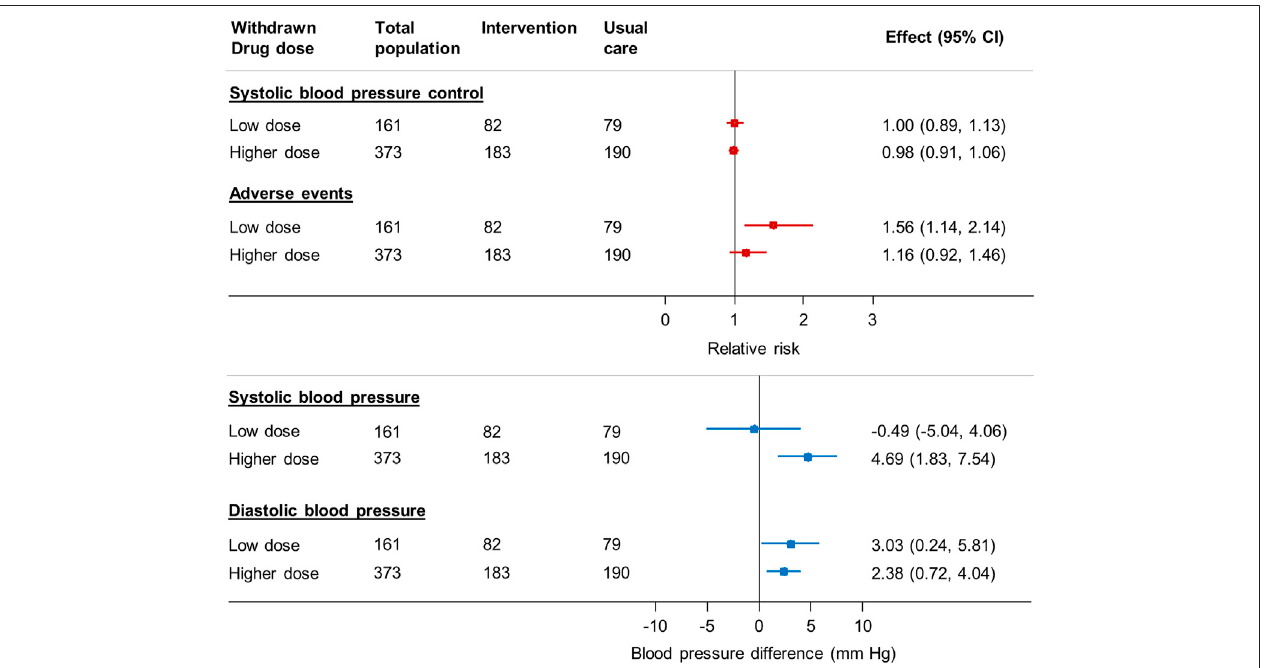
FIGURE4| Relativeriskofbloodpressurecontrol,adverseeventsandmeanchangeinbloodpressureinpatientsreducingantihypertensivemedicationcompared to usual care, by dose of medication chosen for withdrawal* *Since the treating physician ’ s choice of medication to withdraw was made prior to consent and randomization, data were available for all randomized participants, even though only half went on to have the medication withdrawn in the trial. BP (cid:2) blood pressure; CI (cid:2) con fi dence interval Generalized linear mixed model with binomial error and log link, with factors predictive of physician choice of drug to withdraw (see table two) and baseline systolic blood pressure, gender, cognitive function (MoCA Score), EQ-5D-5L Index and Searle Frailty Index as fi xed effects and primary care site as a random